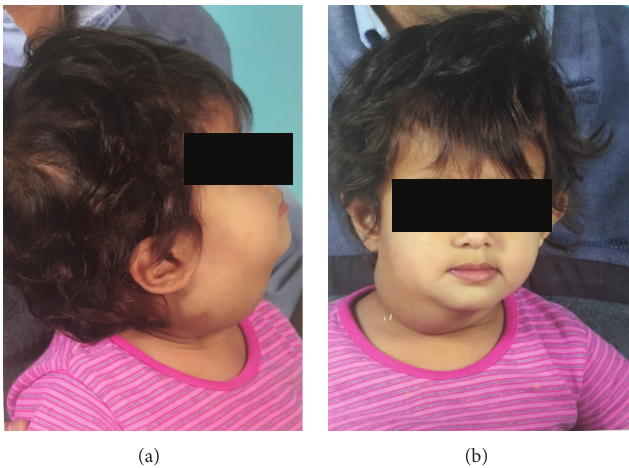
Figure 1: Preoperative clinical photographs of previously excised cystic hygroma in the right neck.